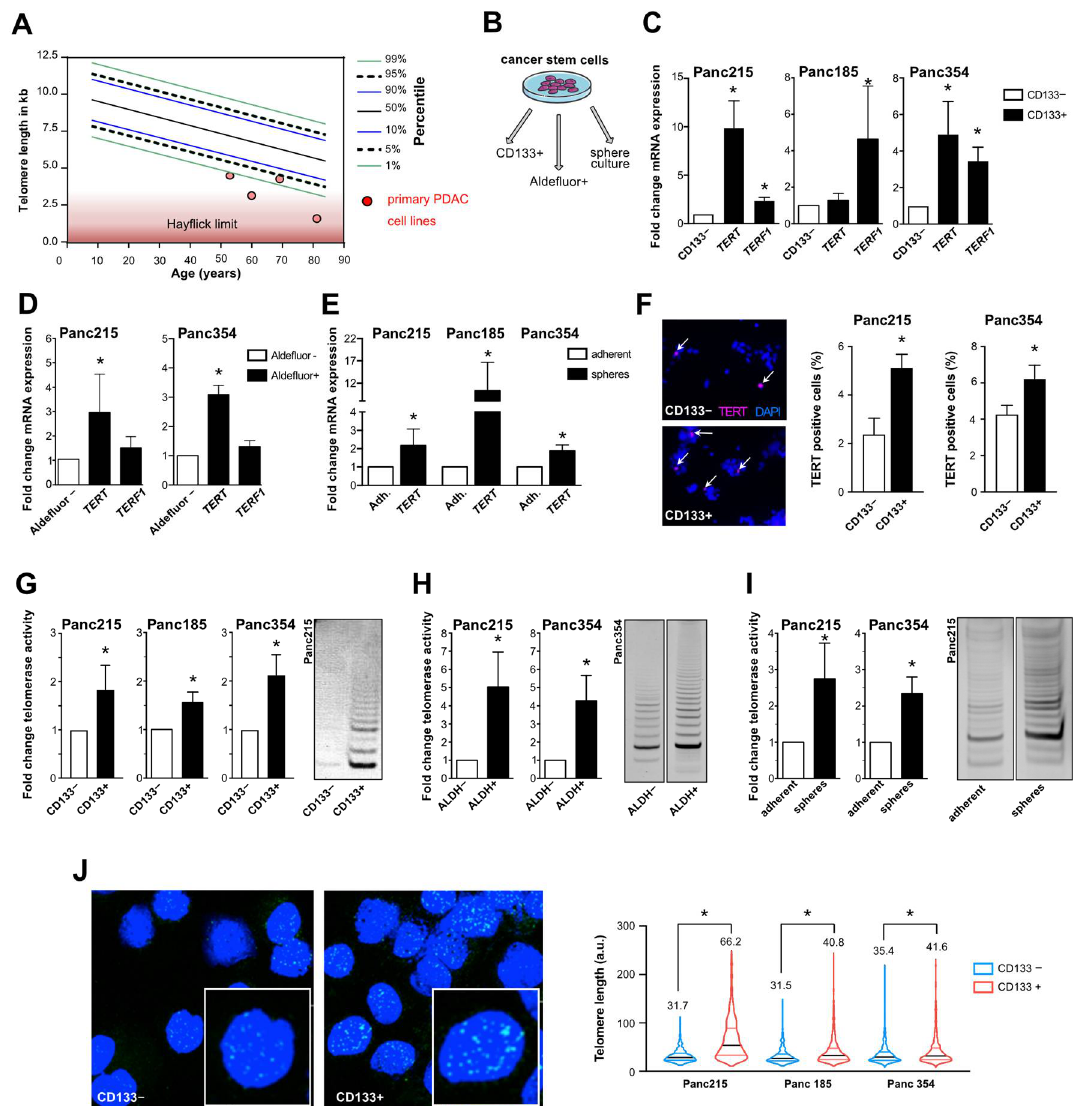
Figure 1. Telomerase activity stabilizes telomere length in pancreatic CSCs: ( A ) telomere length in primary PDAC cells (red dot) with respect to patient age measured by FlowFISH; ( B ) schematic illustration showing the CSC enrichment methods for CD133 and ALDEFLUOR via FACS or in sphere culture; ( C – E ) RT-qPCR analysis of TERT and TERF1 mRNA levels in primary pancreatic cancer stem cells enriched and selected by FACS for CD133 ( C ), or ALDEFLUOR ( D ), and cultured as spheres ( E ) (CSCs) vs. corresponding control (non-CSCs) ( n = at least 3 independent experiments). ( F ) Immunofluorescence staining and quantification for TERT (red) in CD133− and CD133+ FACSorted cells ( n = 5 independent experiments). Cells were counterstained with DAPI (nuclear marker, blue), 4× magnification is shown. ( G – I ) Telomerase activity measurement in CD133 ( G ) or ALDEFLUOR ( H ) negative vs. positive cells and in adherent vs. sphere cell-cultures ( I ) ( n = 3 independent FACSortings and sphere culture experiments). ( J ) Representative pictures of Q-FISH with telomeres (green) and DAPI (blue) and violin plot showing telomere length analysis in CD133 negative (non-CSCs) and positive cells (CSCs) 40× magnification is shown. The mean is depicted in numbers and as black line. n ≥ 3 from independent FACSortings with each >150 measurements per group. In ( C – J ), data are presented as mean ± SEM. * p ≤ 0.05 (Mann–Whitney-U test).